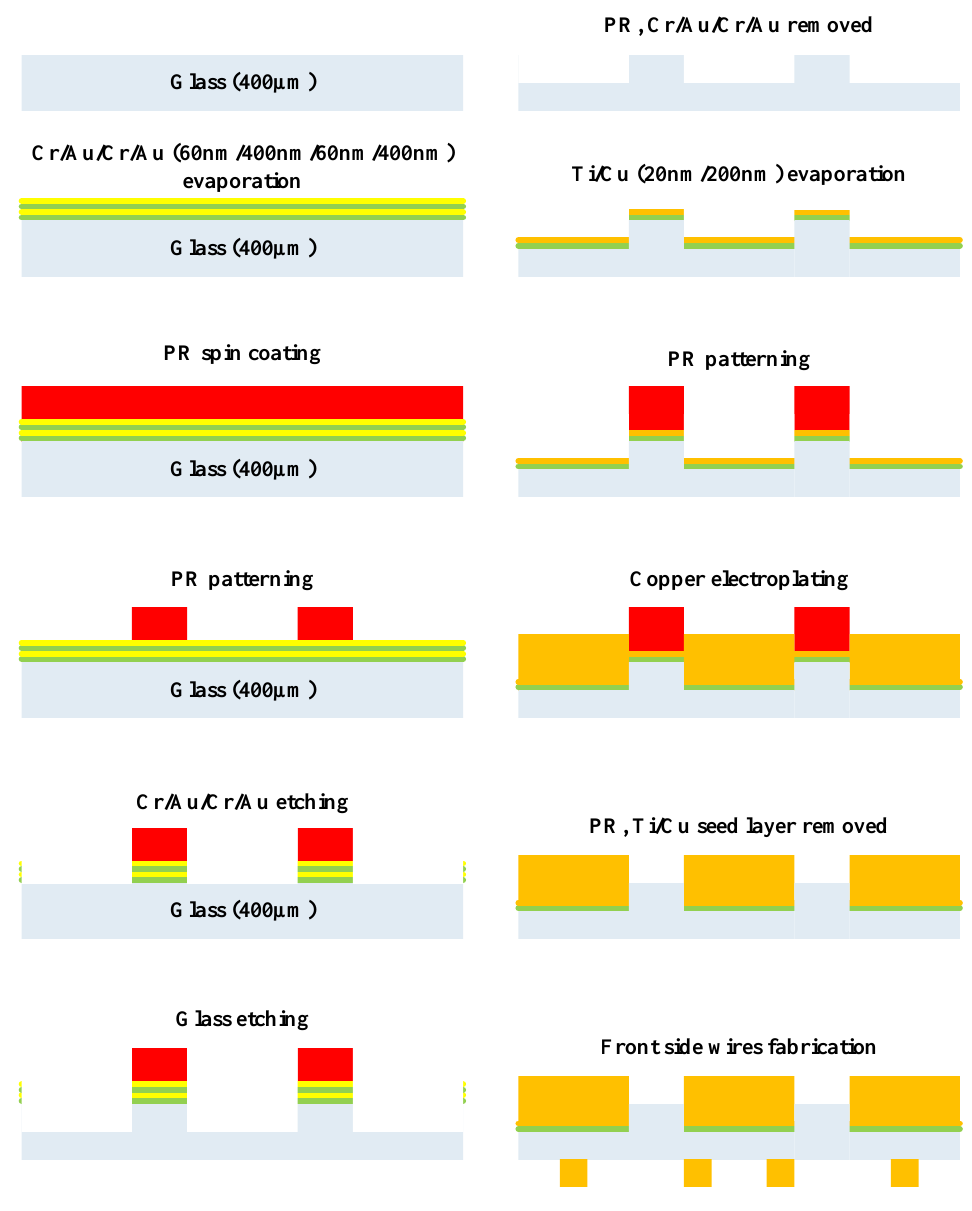
Figure 6. Fabrication process for creating a single layer transparent atom chip with heat dissipation design on the backside (backside